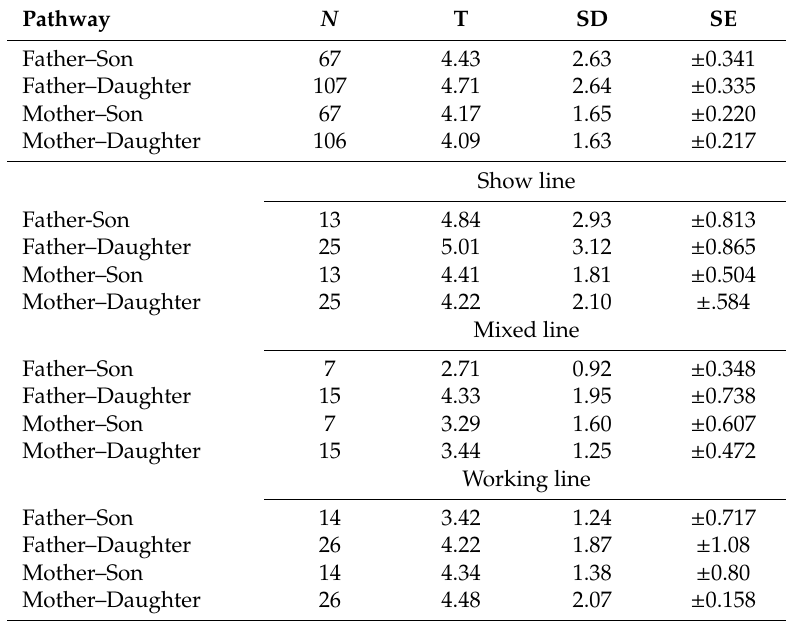
Table 2. Descriptive statistics of the generation interval (T) for the reference population